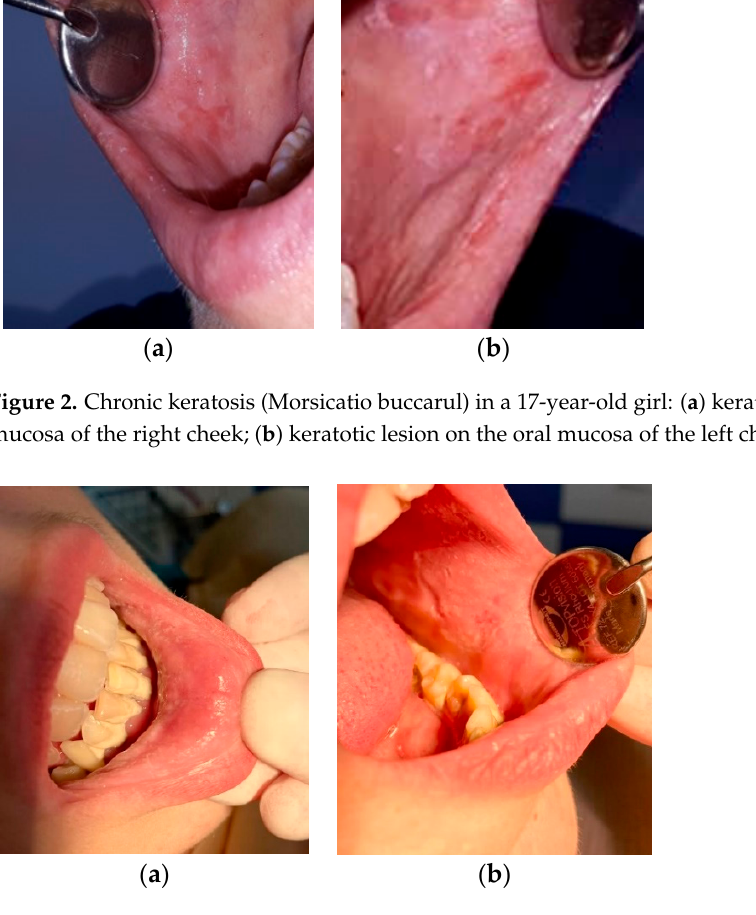
Figure 2. Chronic keratosis (Morsicatio buccarul) in a 17-year-old girl: ( a ) keratotic lesion on the oral mucosa of the right cheek; ( b ) keratotic lesion on the oral mucosa of the left cheek.